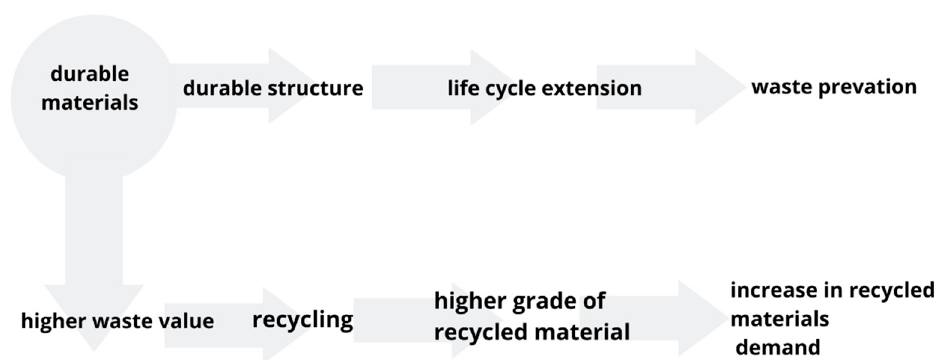
Figure 2. Durability in circular economy.